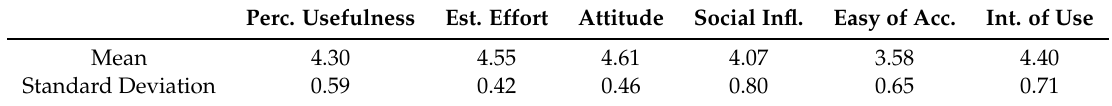
Table 1. Mean and standard deviation for the evaluated indicators. Perc. Usefulness Est. Effort Attitude Social Infl. Easy of